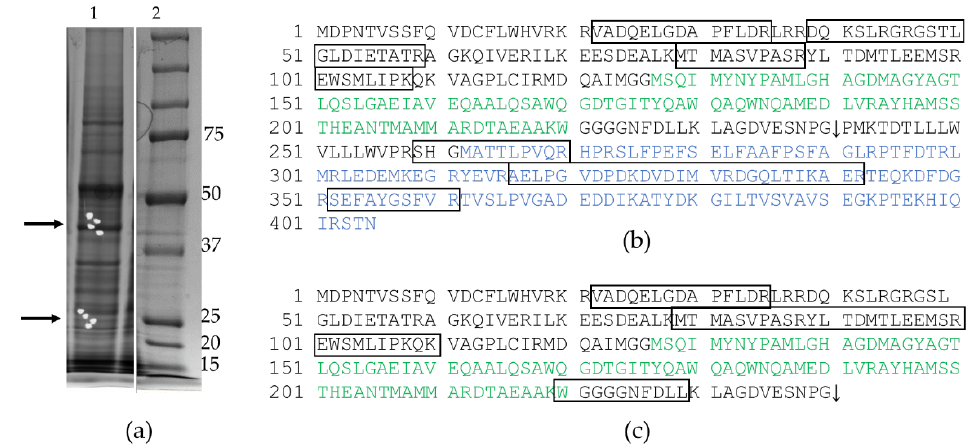
Figure A1. Mass spectrometric analyses of protein expression in cells infected with the Flu/THSP recombinant virus. ( a ) PAAG fragments intended to MS analysis (marked with arrows, see also Figure 1c), lane 1—infected cells, lane 2—marker in kDa; ( b ) The amino acid sequence of NS1-TB10.4-HspX chimeric protein, which was reliably identified in PAAG zones corresponding to the molecular weight of 45 kDa (score/threshold was equal to 108/61); the protein fragments identified in the spectrum are outlined. ( c ) The amino acid sequence of NS1-TB10.4 chimeric protein, which was reliably identified in PAAG zones corresponding to the molecular weight of 26 kDa (score/threshold was equal to 70/61); the protein fragments identified in the spectrum are outlined. Sequences corresponding to TB10.4 antigen and HspX antigen are marked green and blue, respectively. The 2A-site is marked with an arrow.